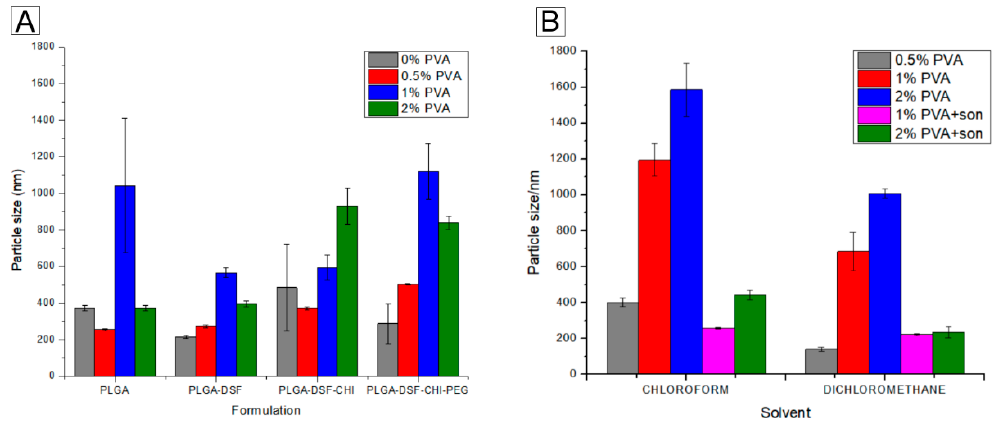
Figure 2. ( A ) Mean particle size obtained for formulations using acetone as the organic phase, and different concentrations of PVA in the aqueous phase. ( B ) Mean particle size obtained for formulations containing PLGA, chitosan and PEG with either chloroform or dichloromethane as the organic phase, different concentrations of PVA in the aqueous phase, and sonication.